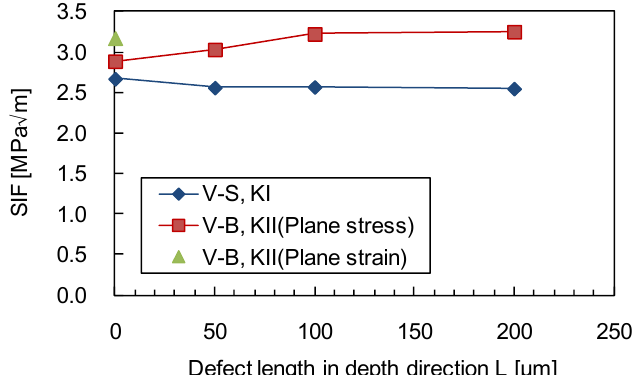
Figure 8: Comparison of Δ K I at the surface edge of vertical crack and Δ K II at the bottom of vertical crack between different defect lengths (V:vertical crack, S:surface, and